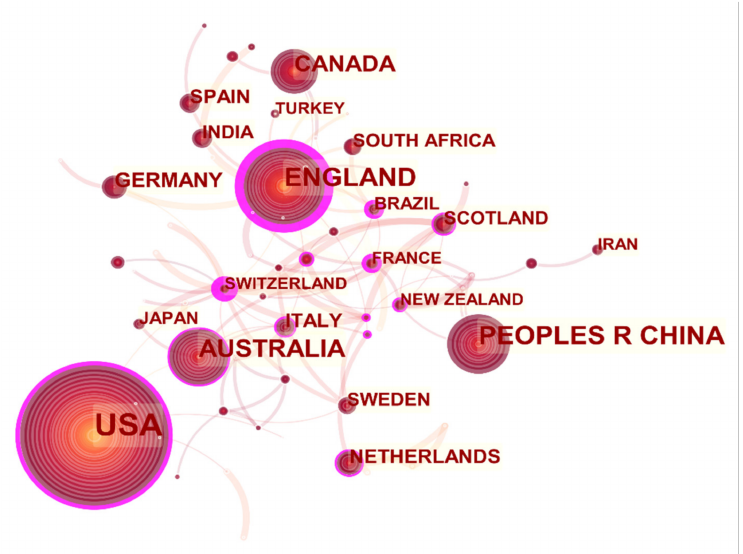
Figure 6. Visualization map of countries participating in healthy urban planning